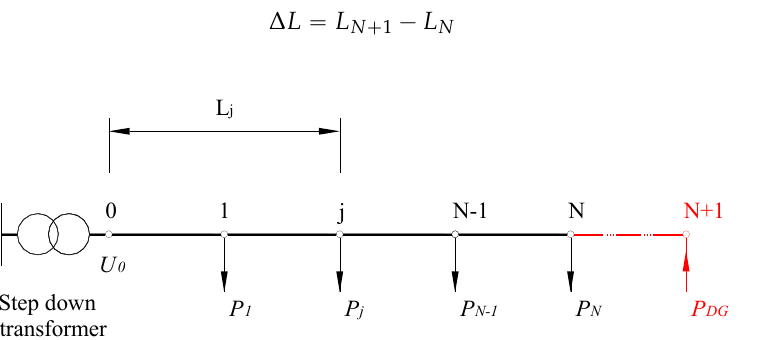
Figure 1. Radial low ‐ tension distribution grid with increased length to include distributed Radial low-tension distribution grid with increased length to include distributed generation (DG). generation